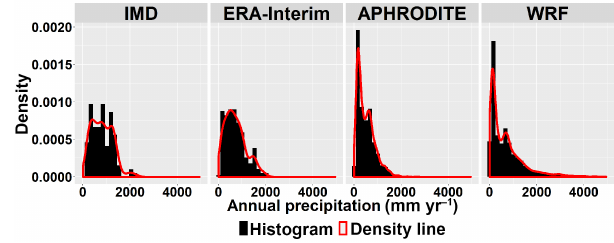
Figure 3. Density curves of mean annual precipitation values in all grid